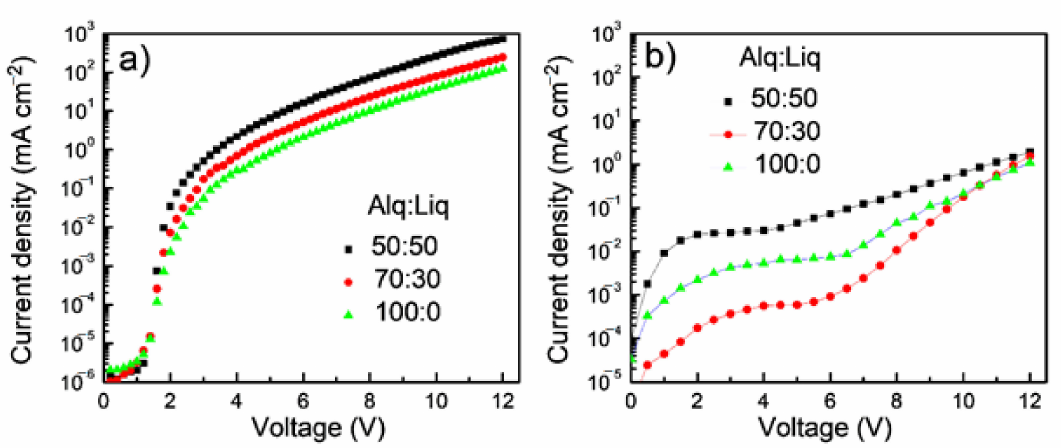
Figure 3. Current density-voltage characteristics of ( a ) electron-only and ( b ) hole-only devices with different weight ratios of Alq 3 :Liq.